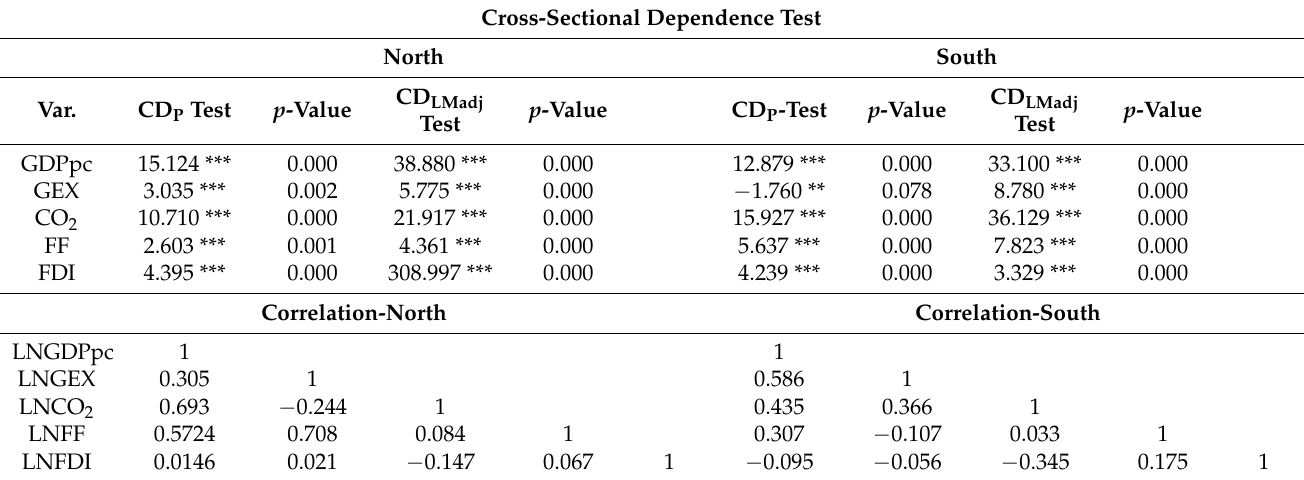
Table 3. Cross-sectional dependency and correlation analysis.